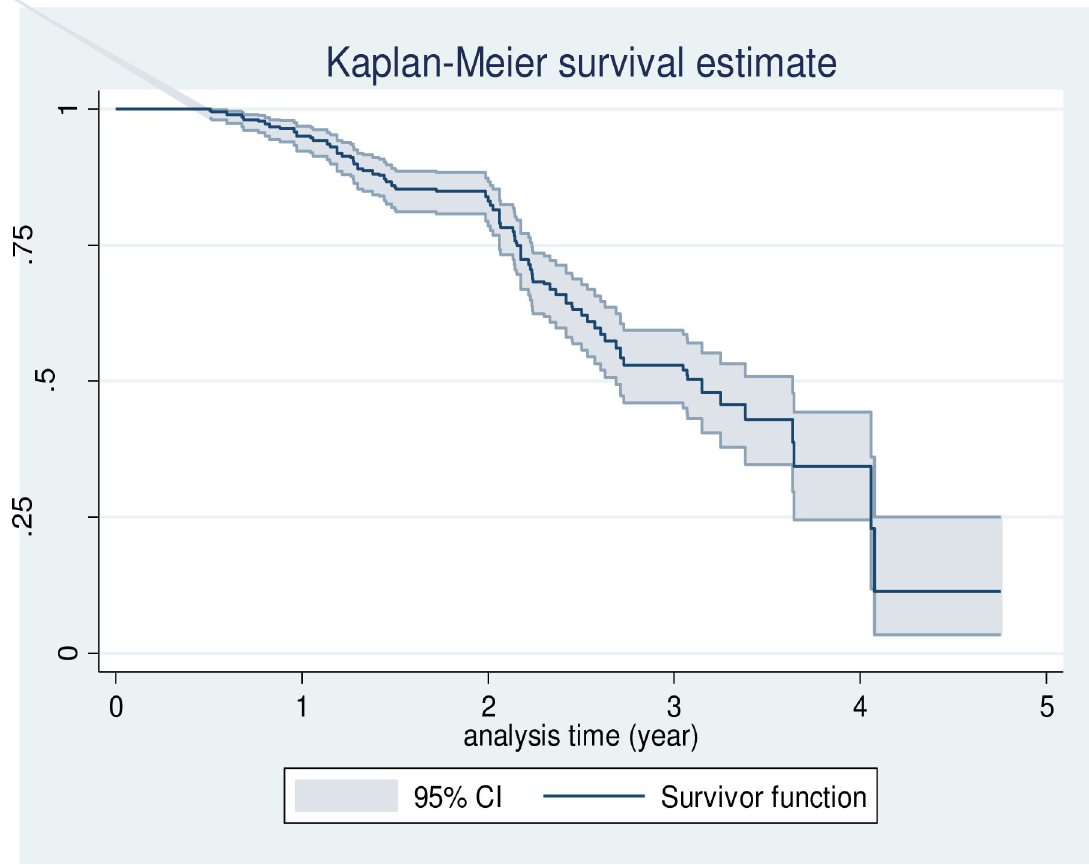
Fig 2. Kaplan-Meier estimation of survival functions among a cohort of breast cancer patients at the referral hospital in northwest Ethiopia.